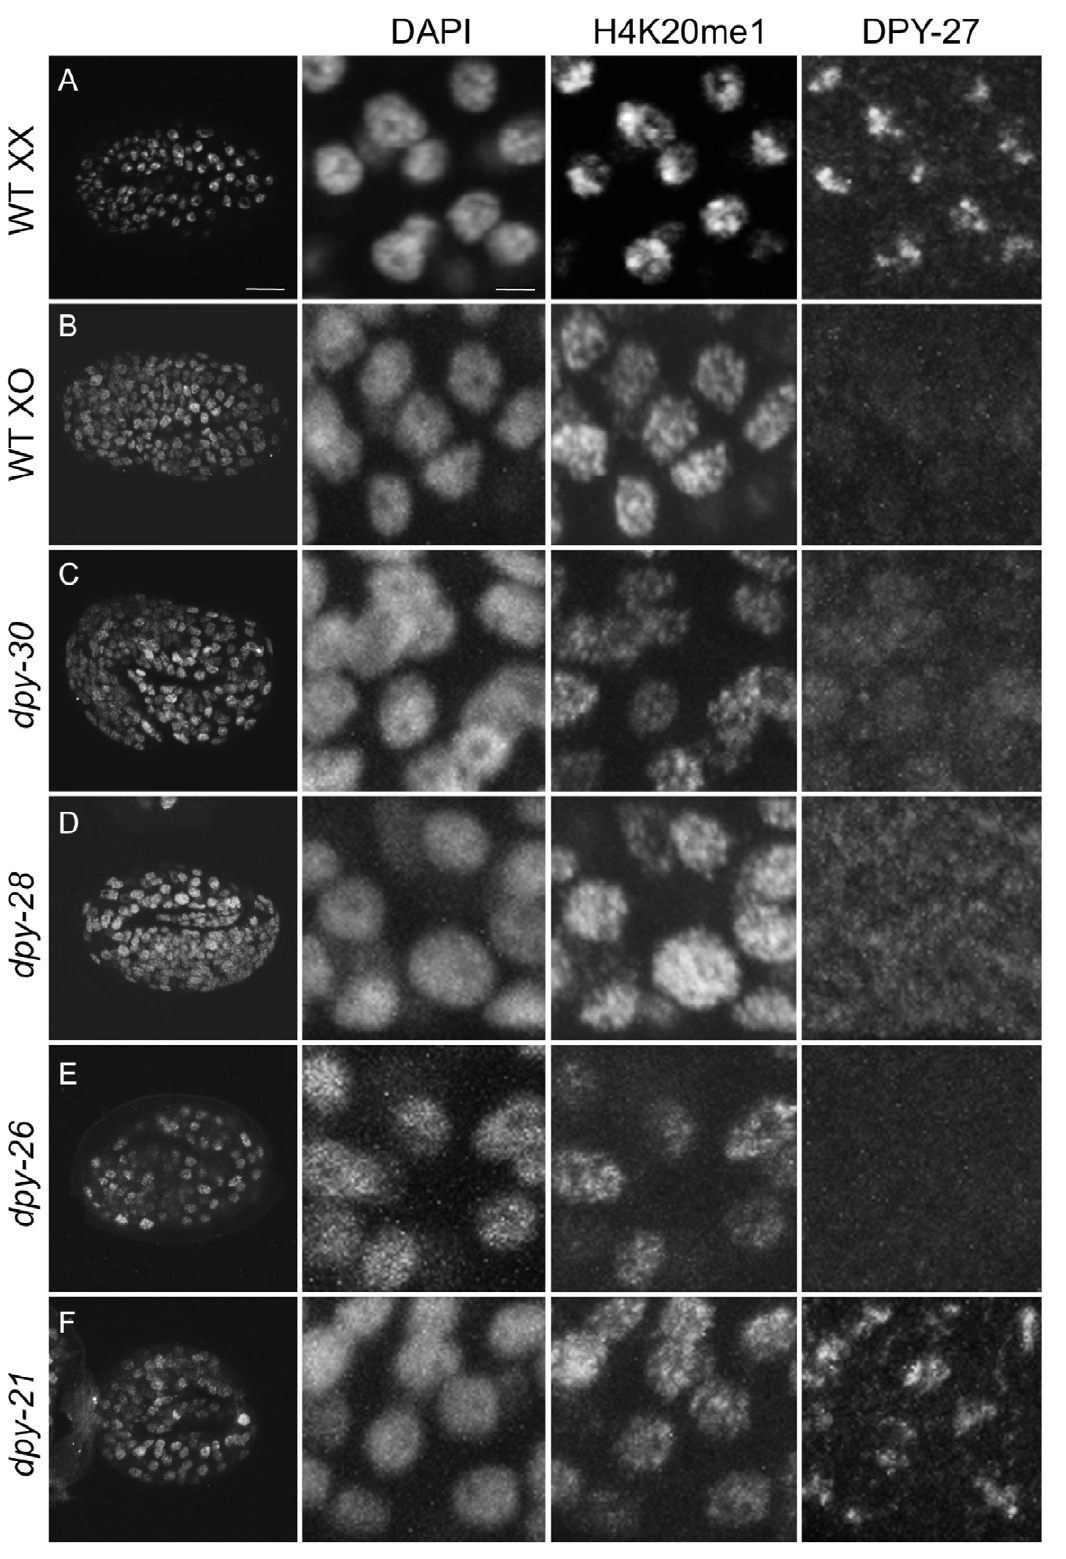
Figure 4. H4K20me1 enrichment to the X chromosome depends on dosage compensation. Three-fold embryos were stained with DAPI and antibodies to DPY-27 and H4K20me1. (A) Wild-type (WT) XX hermaphrodite, (B) him-8 XO male, (C) dpy-30(y228) (D) dpy-28(y1) , (E) dpy-26(n199) , and (F) dpy-21(e428) hermaphrodites. Left panel shows whole embryos, right panels show enlargements of nuclei. Foci of H4K20me1 X-chromosome enrichment are absent in males and dosage compensation mutants. Scale bars represent 10 um (left column) and 2 um (enlargements). Monoclonal antibody 15F11 antibody was used to detect H4K20me1. doi:10.1371/journal.pgen.1002933.g004 PLOS Genetics |